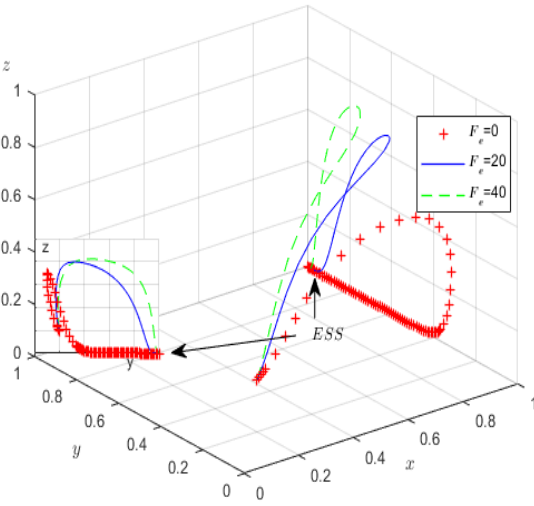
Figure 10. The influence of F e on evolutionary processes.